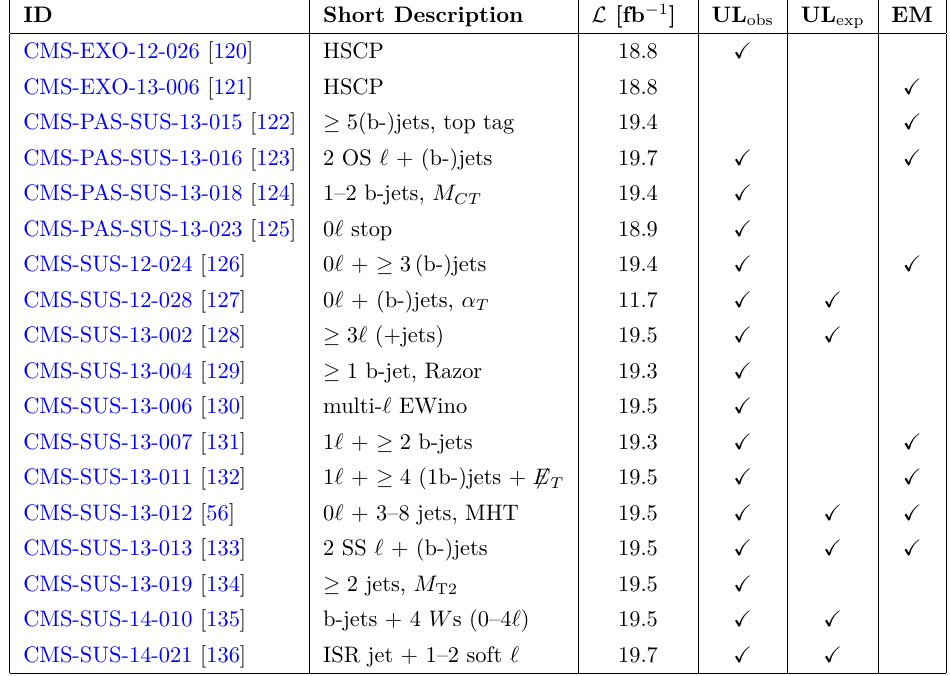
Table 8 . List of CMS Run 1 analyses and their types of results in the SModelS v1.2.4 database. The column “comb.” is omitted as no information on signal region correlations is available for any of the